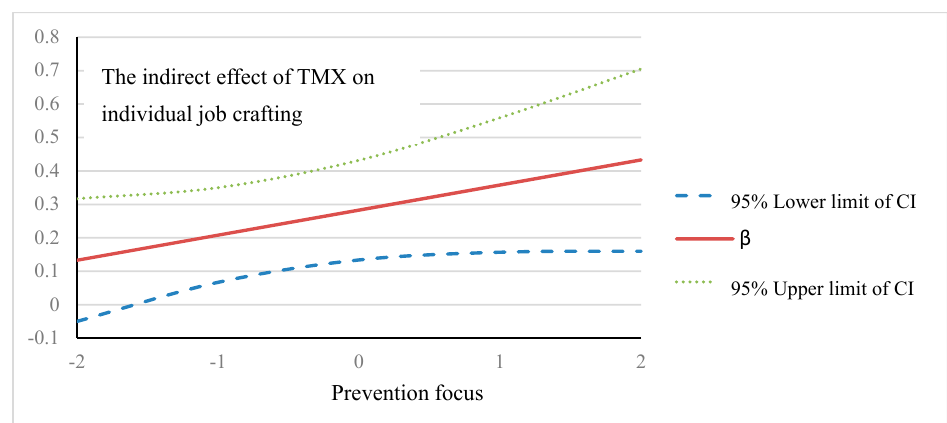
Figure 2. Moderating effect of prevention focus.